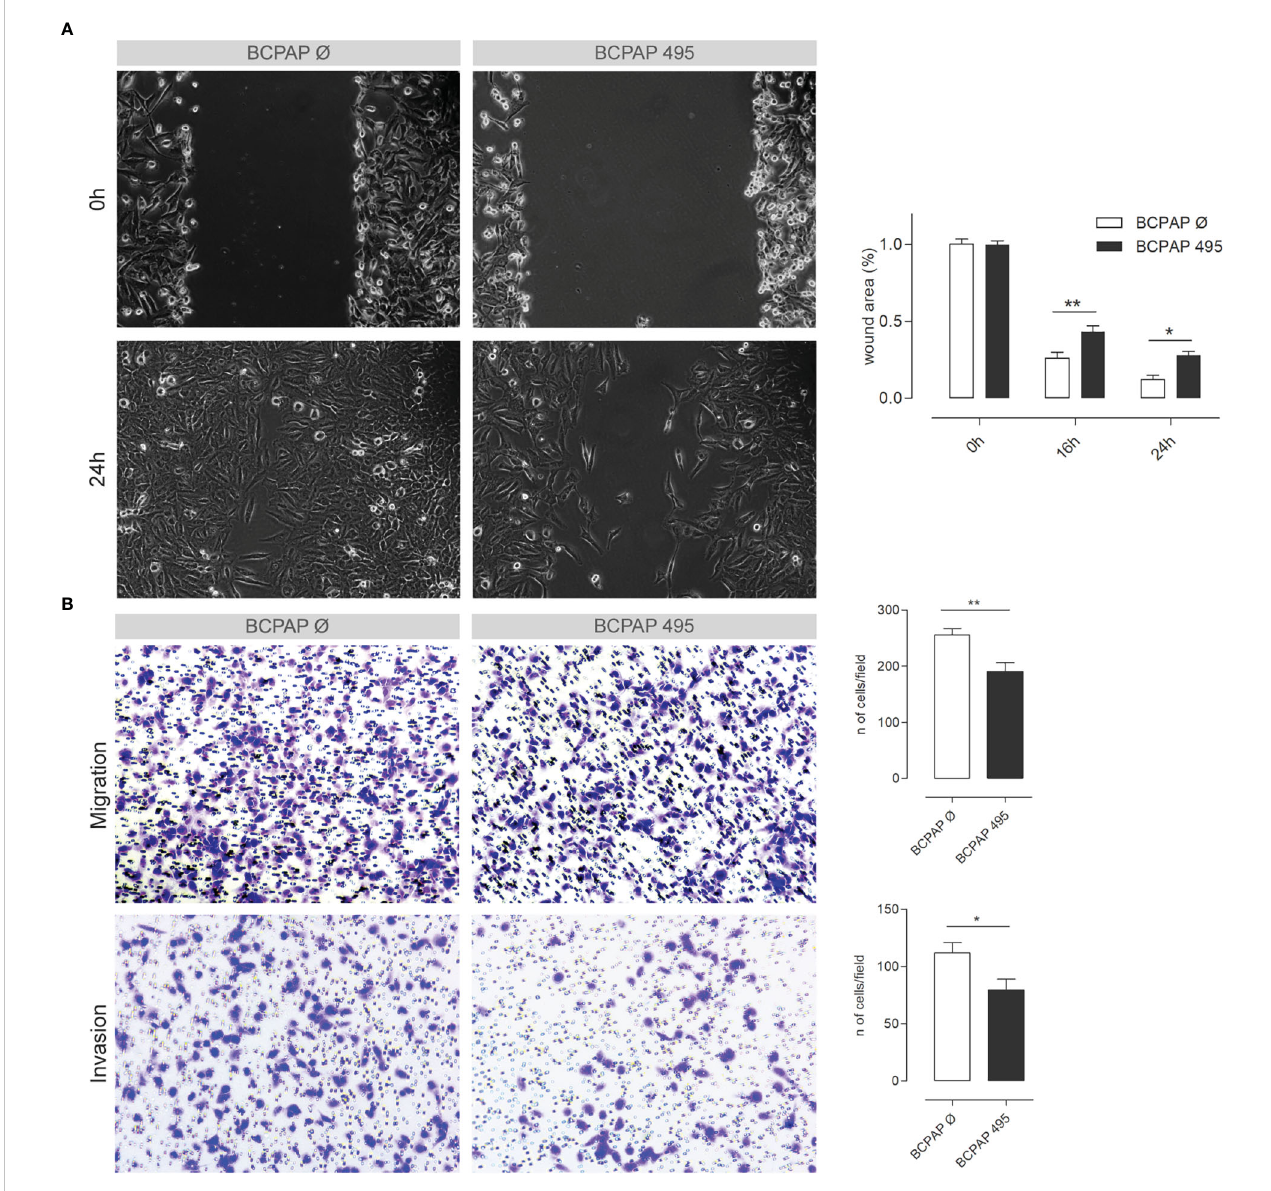
FIGURE 6 miR-495-3p overexpression impairs PTC cell ’ s migration and invasion. (A) Figure shows BCPAP cells stably transfected with miR-495-3p after 0, 16 and 24h of the wound making in the scratch assay. Cells transfected with the empty vector were used as control (40x magni fi cation). Bar plot on the right shows the difference in wound area between the control and transfected groups after 16 and 24h of the wound making. (B) Representative photomicrographs of cells that migrated through the Transwell in the migration and invasion assays (100x magni fi cation). Bar plots on the right show the count of migrated/invaded cells of both control groups and the stably transfected with miR-495-3p . Data is presented as one representative experiment (from three independent experiments), bars represent the standard errors of means (SEMs). Student ’ s t tests were used to compare values between the two groups (*P<0.05,